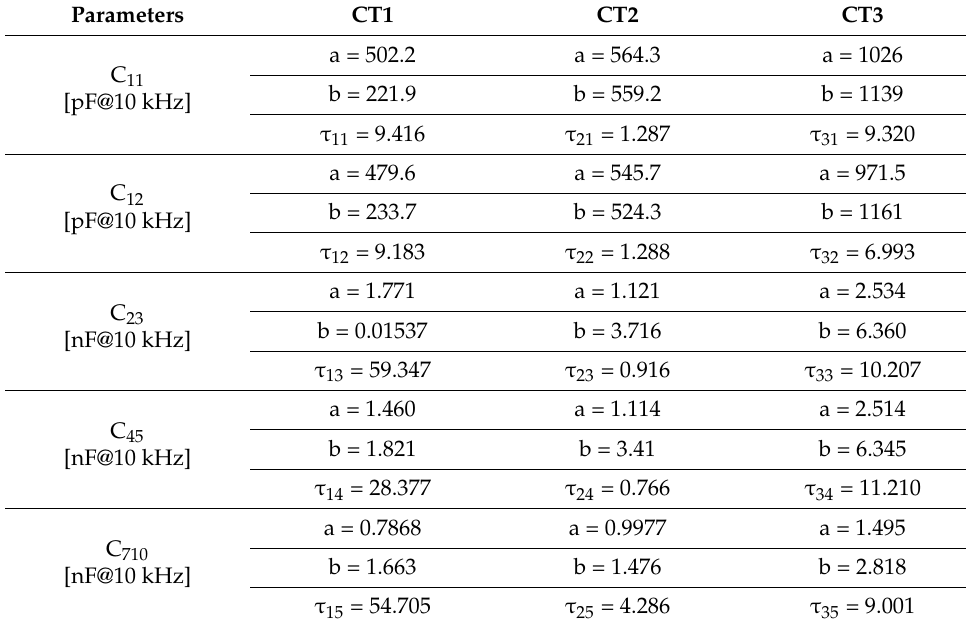
Table 6. Formula of degradation function approximations using function f 3 ( t )